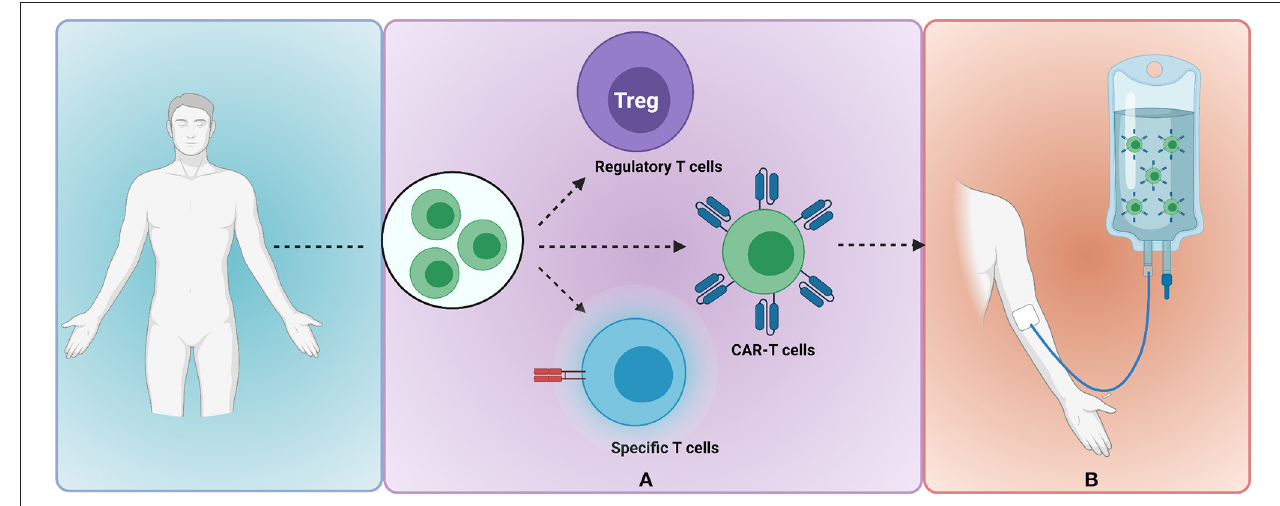
FIGURE 1 | Donor-recipient immunocellular therapy to mitigate risk of leukaemia relapse. (A) Donor-derived T cells are selected and undergo modification or engineering to produce clonally expanded T cells of a specified subset e.g., regulatory T cells, CAR-T cells or T cells with externally inducible safety switch (B) adoptive transfer of modified T cells to the recipient. Image created with BioRender.com. CAR, chimeric antigen